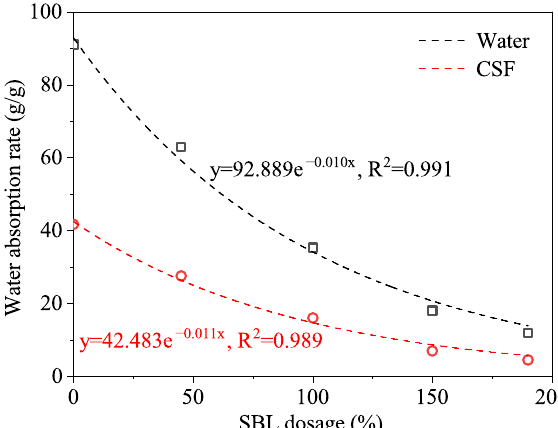
Figure 8. The effect of SBL dosage on SAP’s absorption rate at 90 ◦